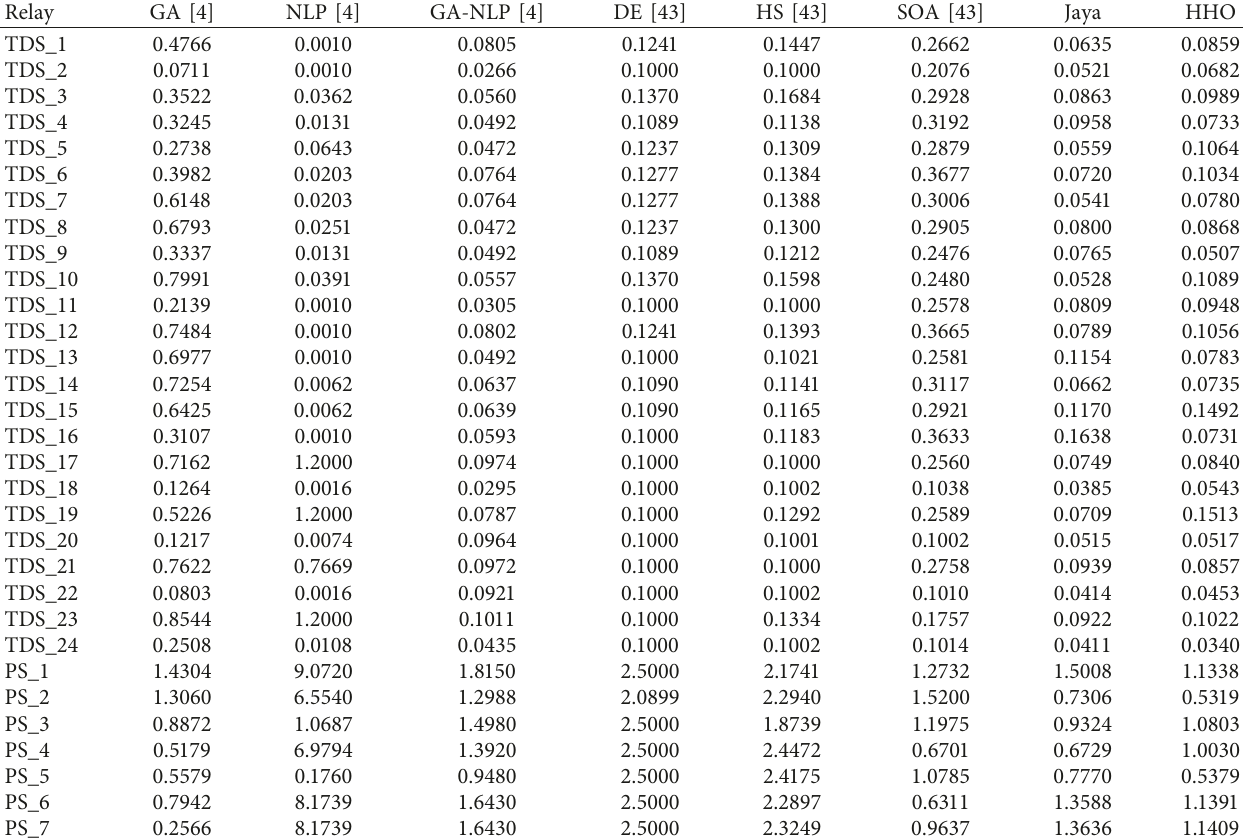
Table 15: Time dial setting and pickup current for the 9-bus system by NLP